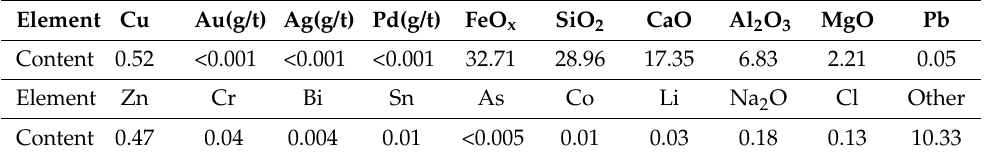
Table 5. Chemical composition of the smelting slag,